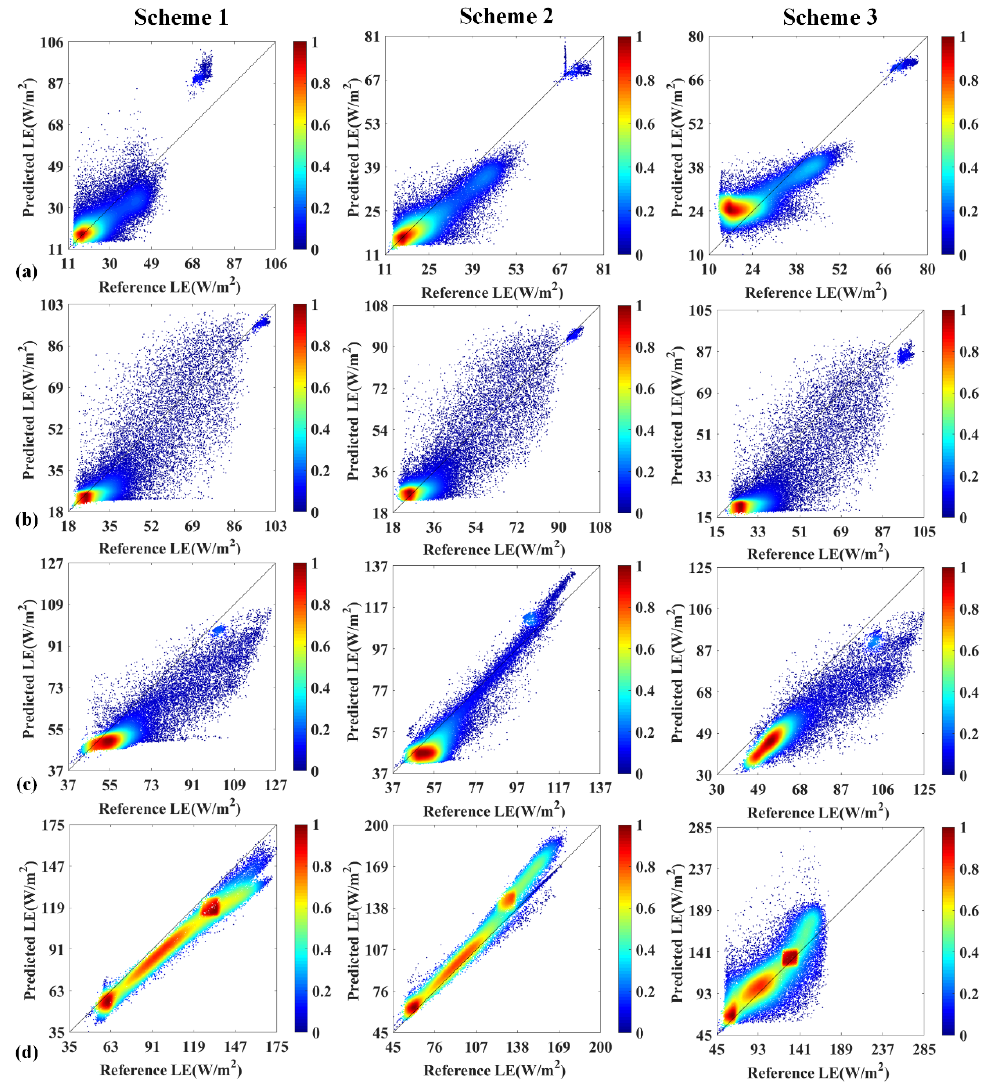
Figure 6. Scatter plots of comparison between the estimated LE vs. GF-1 reference LE on a pixel basis. ( a ) 2015/269, ( b )2016/149, ( c )2017/133, ( d )2017/193 (in Year/DOY format).